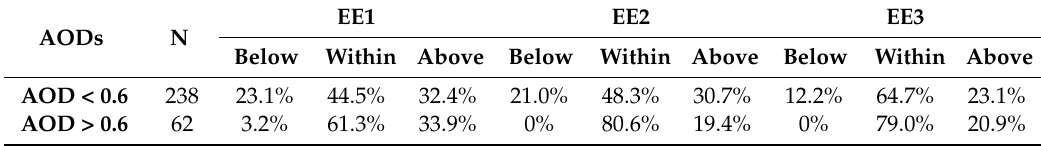
Table 3. Proportions of match-ups below, within and above the EEs for AOD < 0.6 and > 0.6. EE1 EE2 EE3 AODs N Below Within Above Below Within Above Below Within Above AOD < 0.6 238 23.1% 44.5% 32.4% 21.0% 48.3% 30.7% 12.2% 64.7% 23.1% AOD > 0.6 62 3.2% 61.3% 33.9% 0% 80.6% 19.4% 0% 79.0%